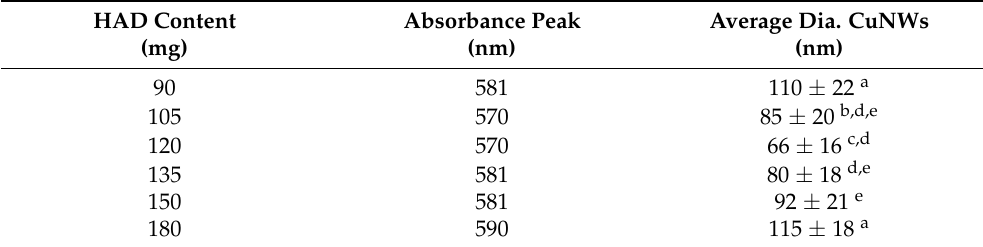
Table 1. The dependence of average diameter of CuNWs with dispersion agent HDA content. Diameter of CuNWs (N = 20). Values are the mean ± standard deviation. Mean values followed by the same superscript letter do not significantly differ ( p > 0.05) according to post-hoc test.